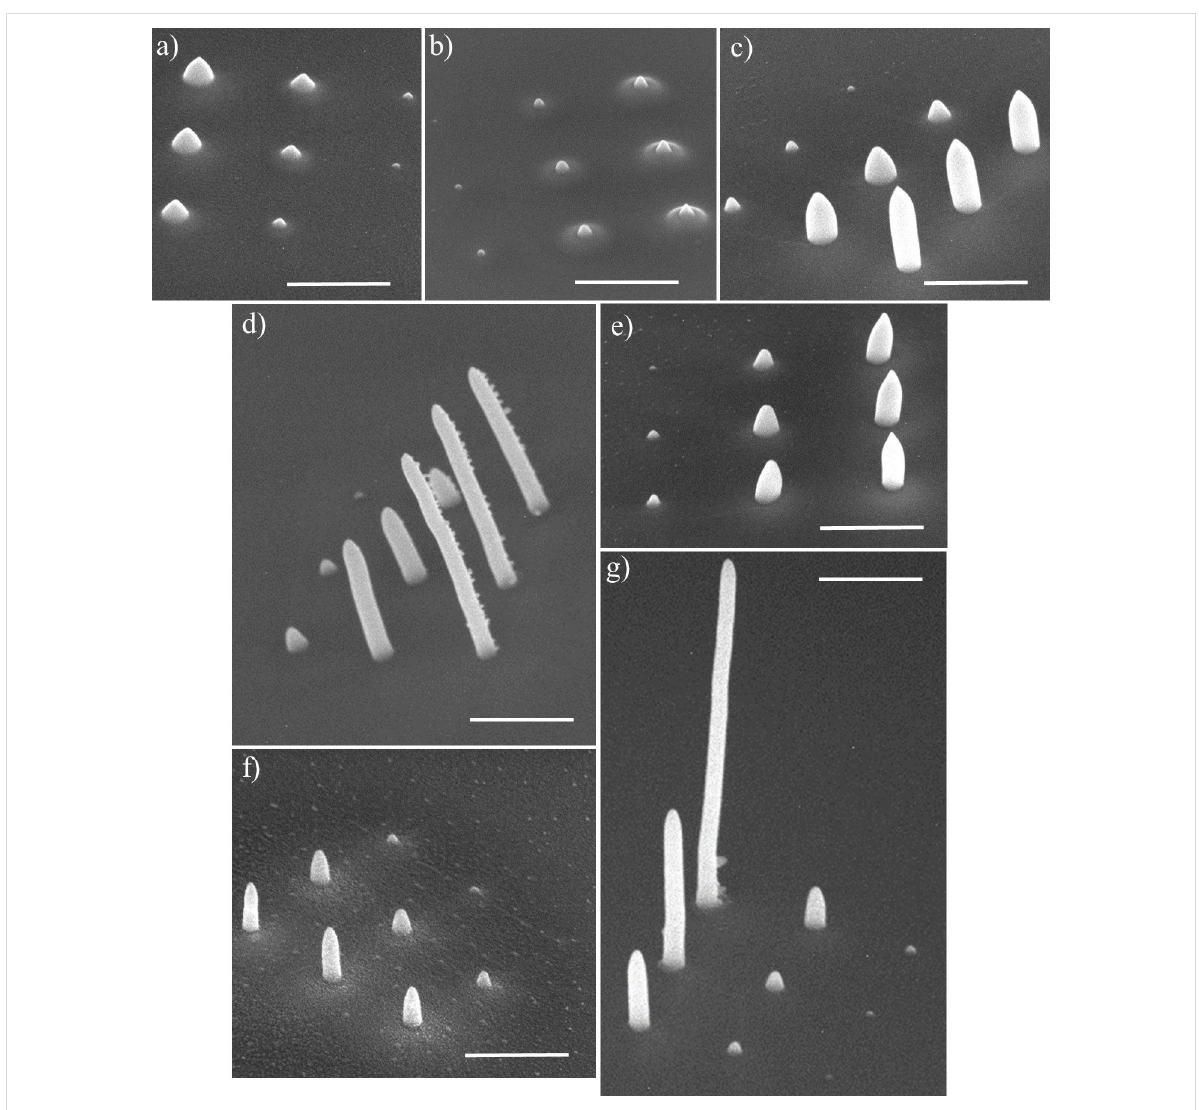
Figure 6: Typical SEM images, tilted by 50°, of pillar arrays deposited from all precursors. (a) 1 (Cl,Me)AuCl, (b) 2 (Cl,Et)AuCl, (c) 3 (Cl,iPr)AuCl, (d) 4 (Cl,Et)AuBr, (e) 5 (Cl,Et)AuI, (f) 6 (N,Et)AuCl, and (g) 7 (Cl,Et)AuCF 3 . The deposition was performed using the reservoir-on-substrate setup heated to 100 °C for all compounds except for 1 , which was heated to 120 °C. The scale bars are 1 µm.